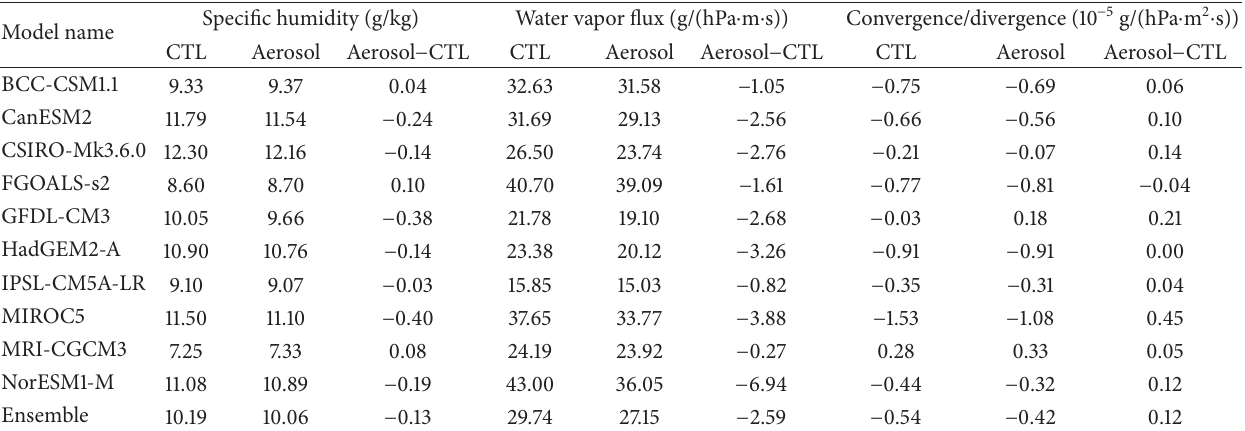
Table 4: Comparisons between the aerosol run and the CTL run in East China in terms of specific humidity, moisture flux, and convergence/divergence at 850 hPa.